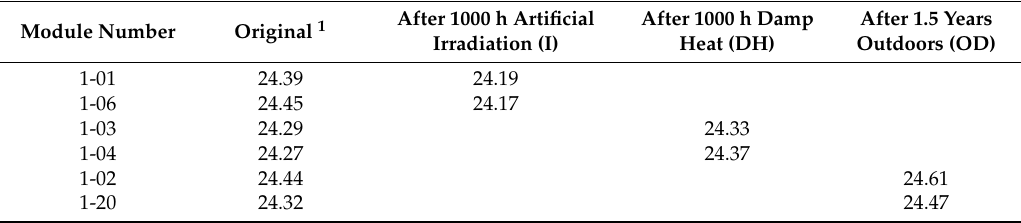
Table 1. Power output in [W] at the maximum power point (P MPP ) (measured under standard test conditions) of the test modules without defects, before and after ageing.